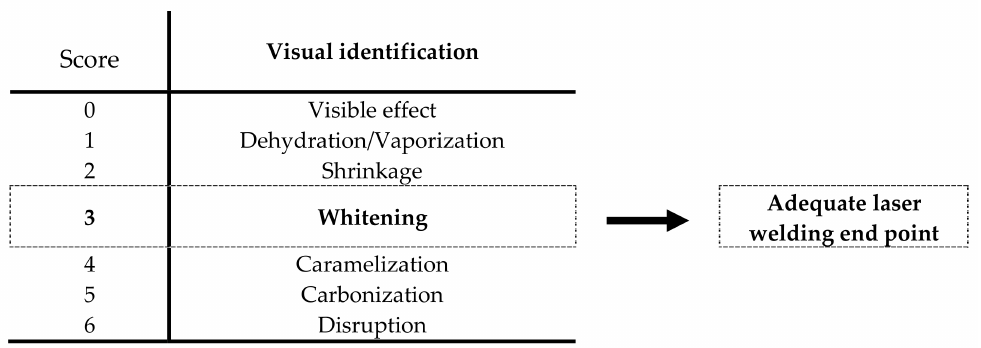
Figure 3. Visual identification scores and adequate laser-welding end point [45,56].